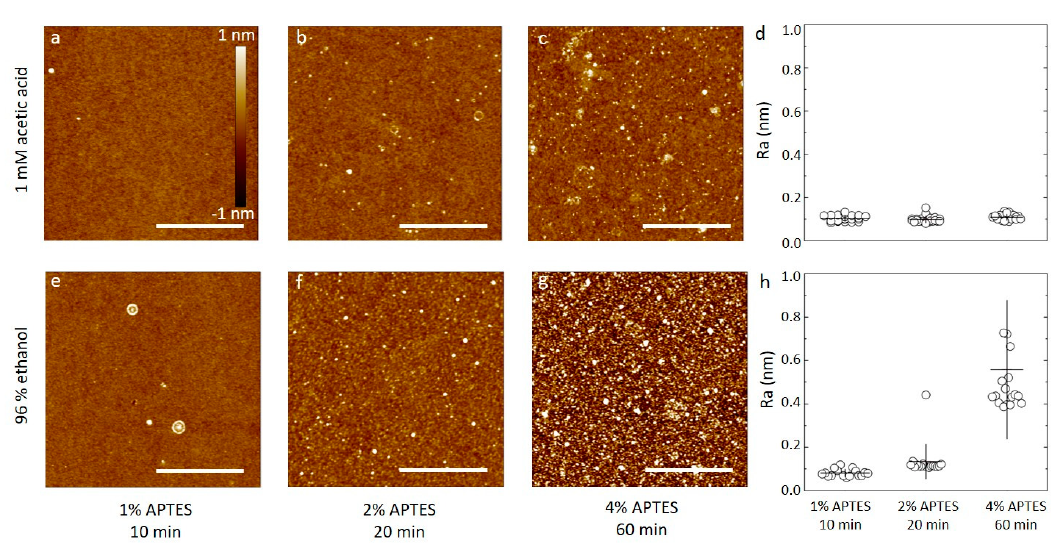
Figure 2. XP spectra results for crystalline silicon silanized with APTES using acetic acid as the silanization solvent. ( a ) Si 2p spectra. ( b ) O 1s spectra. ( a , b ) The results are displayed with the curve